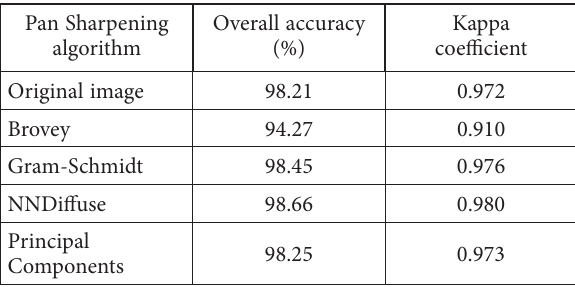
Table 2. Accuracy assessment analysis